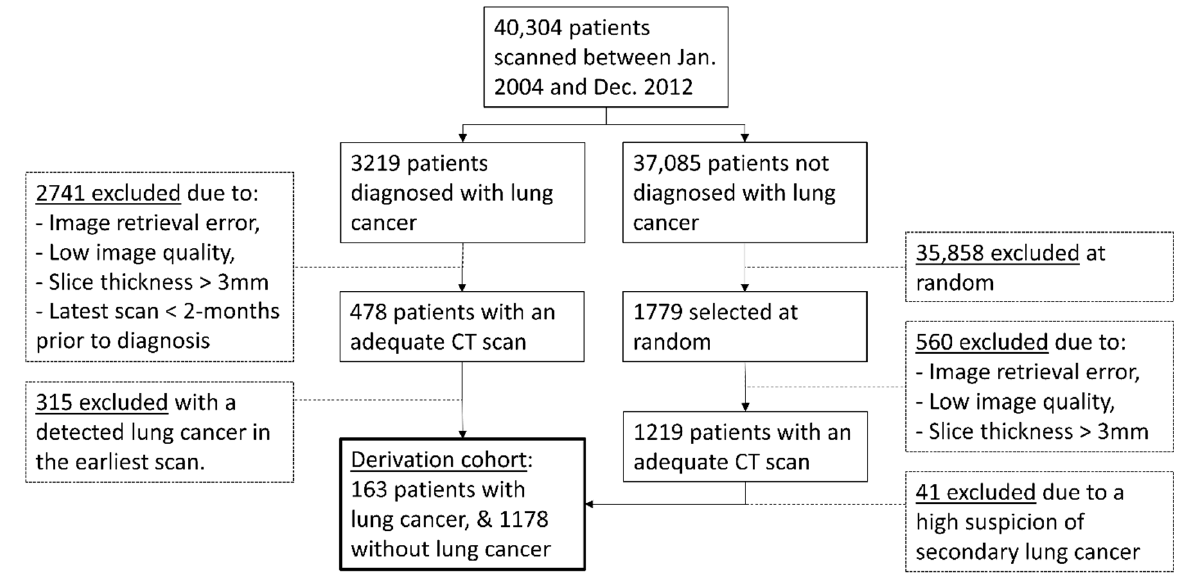
Figure 1. Patient selection flowchart.